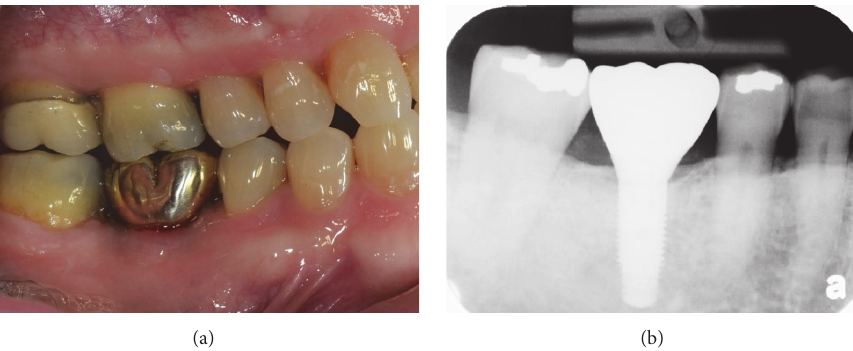
Figure 6: One-year follow-up after crown delivery. There is no evidence of inflammation or symptoms (a). Crestal bone loss or typical retrograde peri-implantitis was not noted on the periapical radiograph